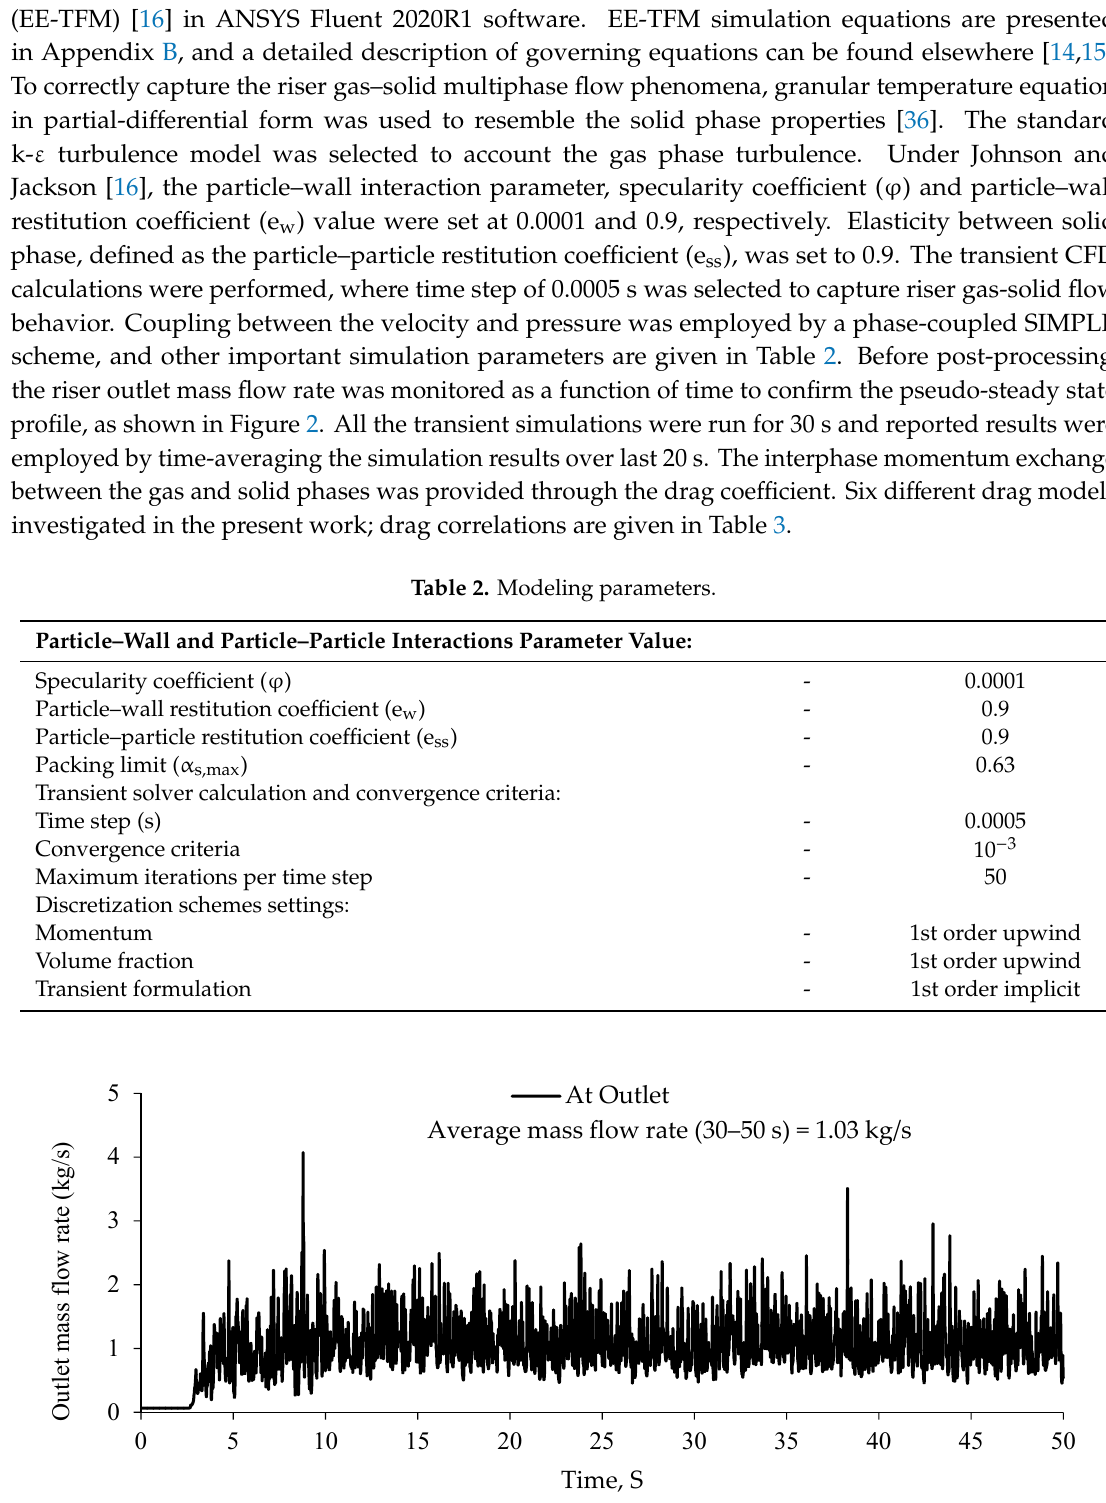
Figure 2. CFB riser outlet mass flow rate as a function of time.